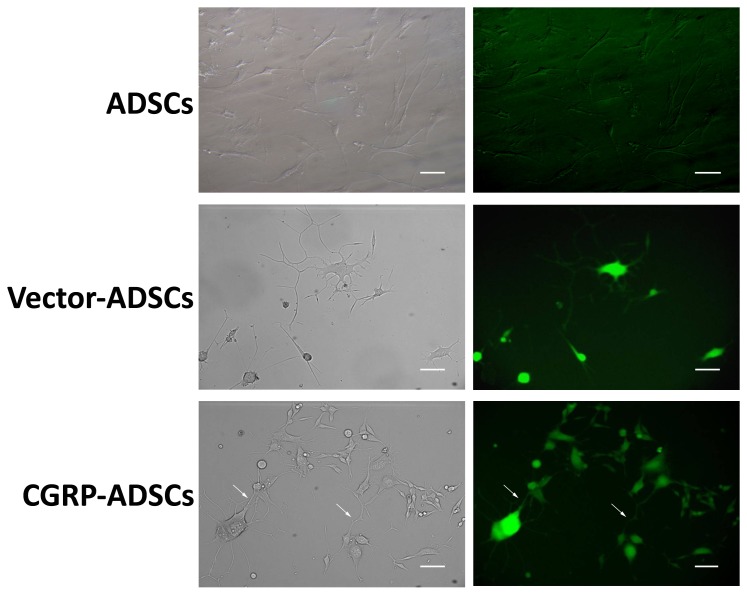
Effect of CGRP on morphological changes of ADSCs on neural induction.On light microscopy or fluorescence microscopy on day 3 after neural induction, ADSCs develop characteristic round cell bodies with several branching extensions on day 3 after neural induction; Specially, the CGRP-ADSCs exhibited more branching extensions on contacting with neighboring cells widely (as show on white arrows). Scale bars = 50 µm.